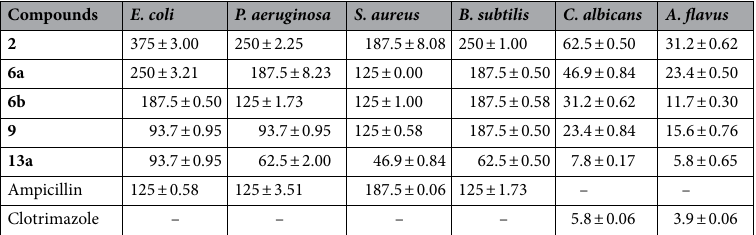
Table 3. Minimum inhibitory concentration (MIC) in (μg/mL) for compounds 2 , 6a , 6b , 9 , and 13a a . a The experiment was carried out in triplicate and the average was